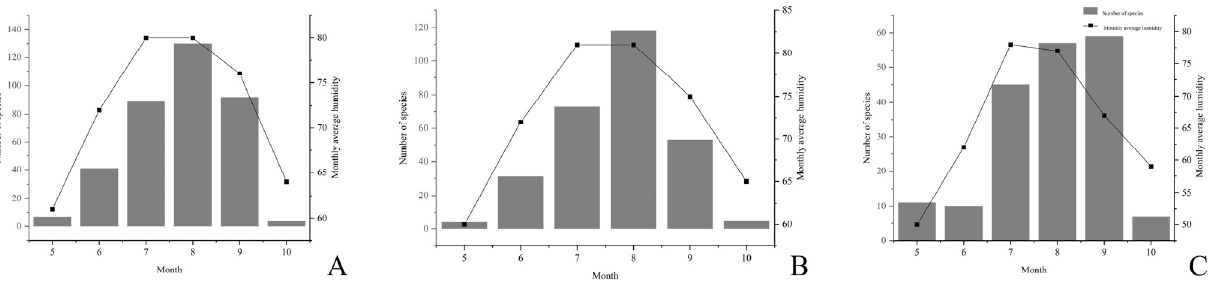
Figure 10. Effect of air humidity on the occurrence of macrofungi in three different investigation sites from Jilin Province. ( A ) Quanshuidong Forest Farm; ( B ) Shengli River Forest Farm; ( C ) Jingyuetan National Forest Park.